Question: Write the caption for this figure.
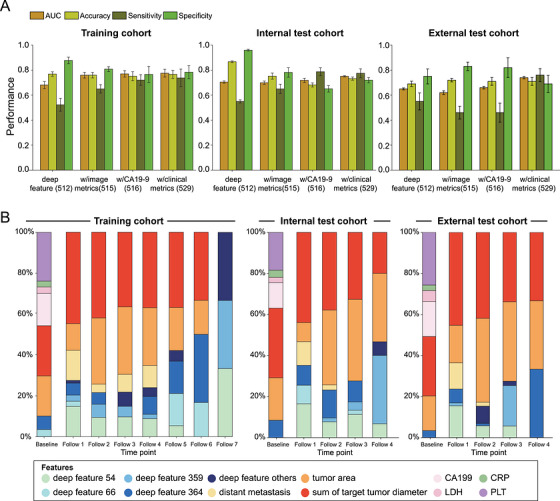
Answer: Performance comparison of models built with different feature combinations and feature contribution analyses. (A) Grouped bar charts showing the performance of different feature combinations. (B) Stacked bar charts of feature contributions across time points. X‐axis: follow‐up time‐points; Y‐axis: relative importance proportion. Color‐coded bars represent multimodal features. CRP, C‐reactive protein; LDH, lactate dehydrogenase; PLT, platelet count.